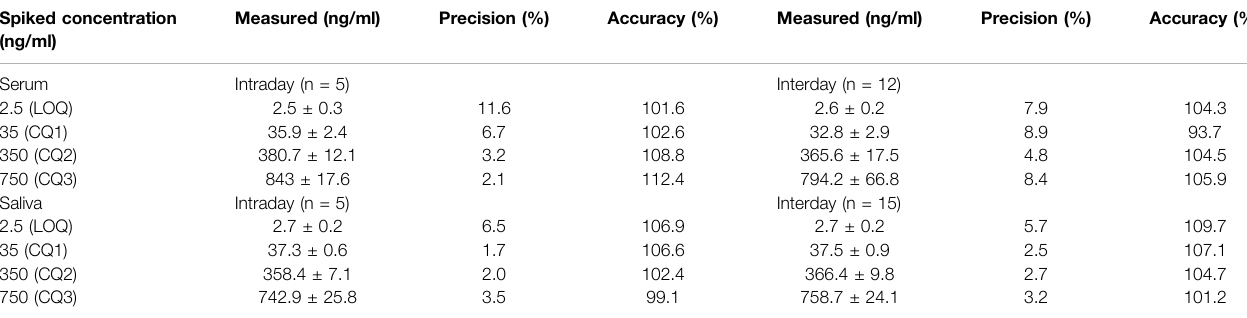
TABLE 2 | Intraday and interday precision and accuracy of CBD in human serum and saliva. Spiked concentration (ng/ml)